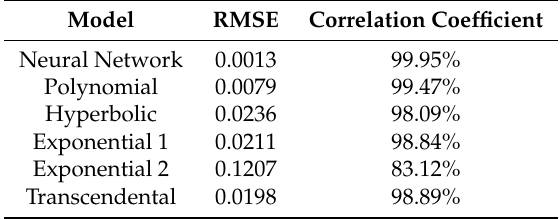
Figure 5. The performance of magnetization curves fitting with different models including DNN, 3rd degree polynomial, hyperbolic, two exponential functions, and transcendental functions. Table 1. Performance of different magnetization curve